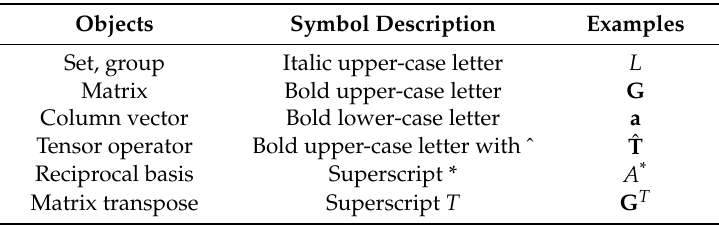
Table 1. Mathematical objects and